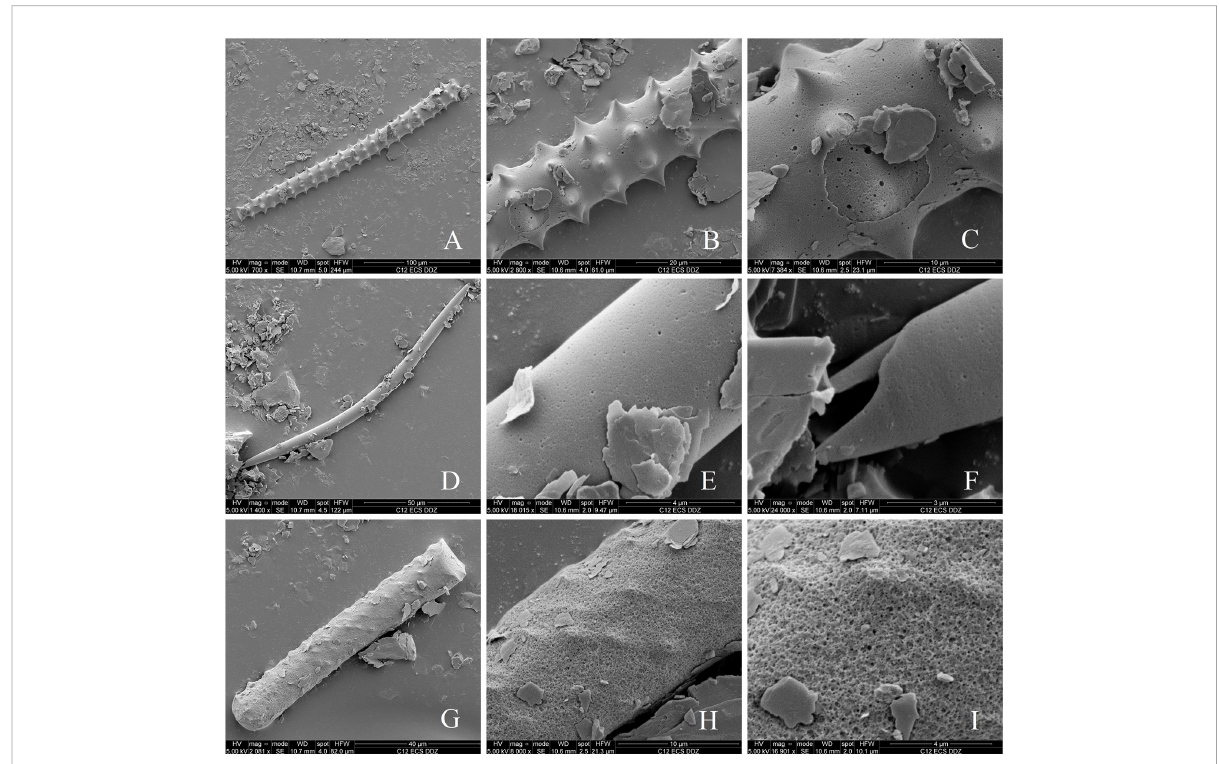
FIGURE 8 SEM images of three types of siliceous sponge spicule structures observed in the residual sediment of sample C12 after 8 h digestion using 2.0 M Na 2 CO 3 (P). (A-C) acanthostyle sponge spicule, (D-F) tignule sponge spicule, (G-I) : strongyle sponge spicule. (B, C, E) and (F, G, I) are zoom- in views of images (A, D, G) ,